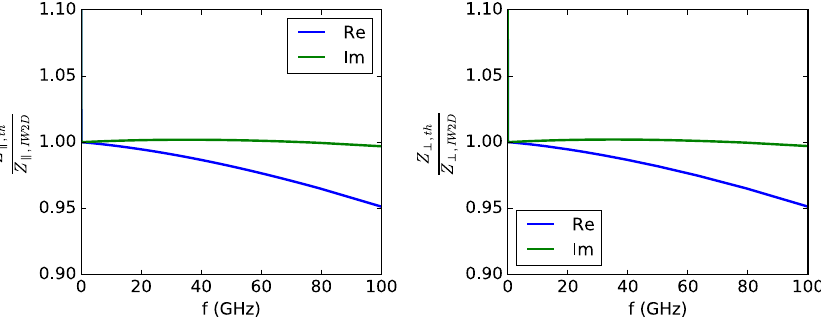
FIG. 1. Ratio of the impedance given by Eq. (8) (left side) and by Eq. (9) (right side) with respect to the results of I MPEDANCE W AKE 2 D. In blue the real part of the impedance is represented, and in green the imaginary one. A copper pipe of 35 mm of radius with a coating conductivity of σ 1 ¼ 2 × 10 6 S = m and a thickness of 100 nm has been